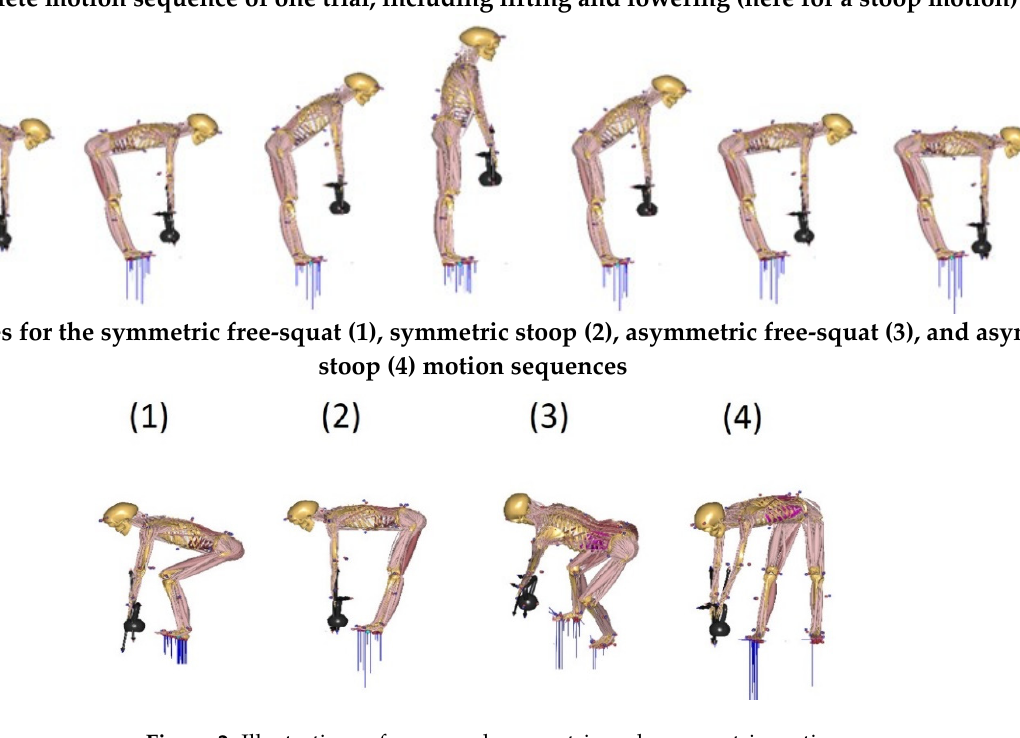
Figure 2. Illustrations of measured symmetric and asymmetric motion sequences.